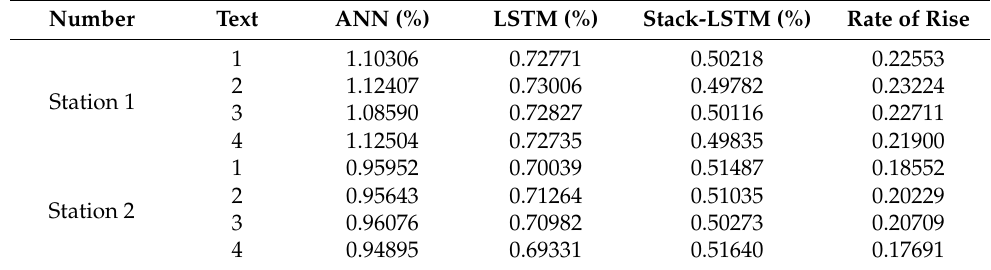
Table 2. Comparison of multi-model MAPE.